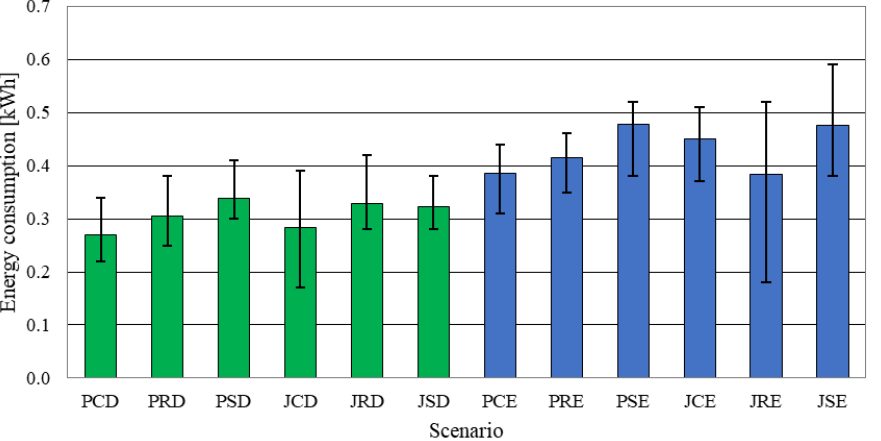
Figure 6. Energy consumption depending on the use of the motion platform.